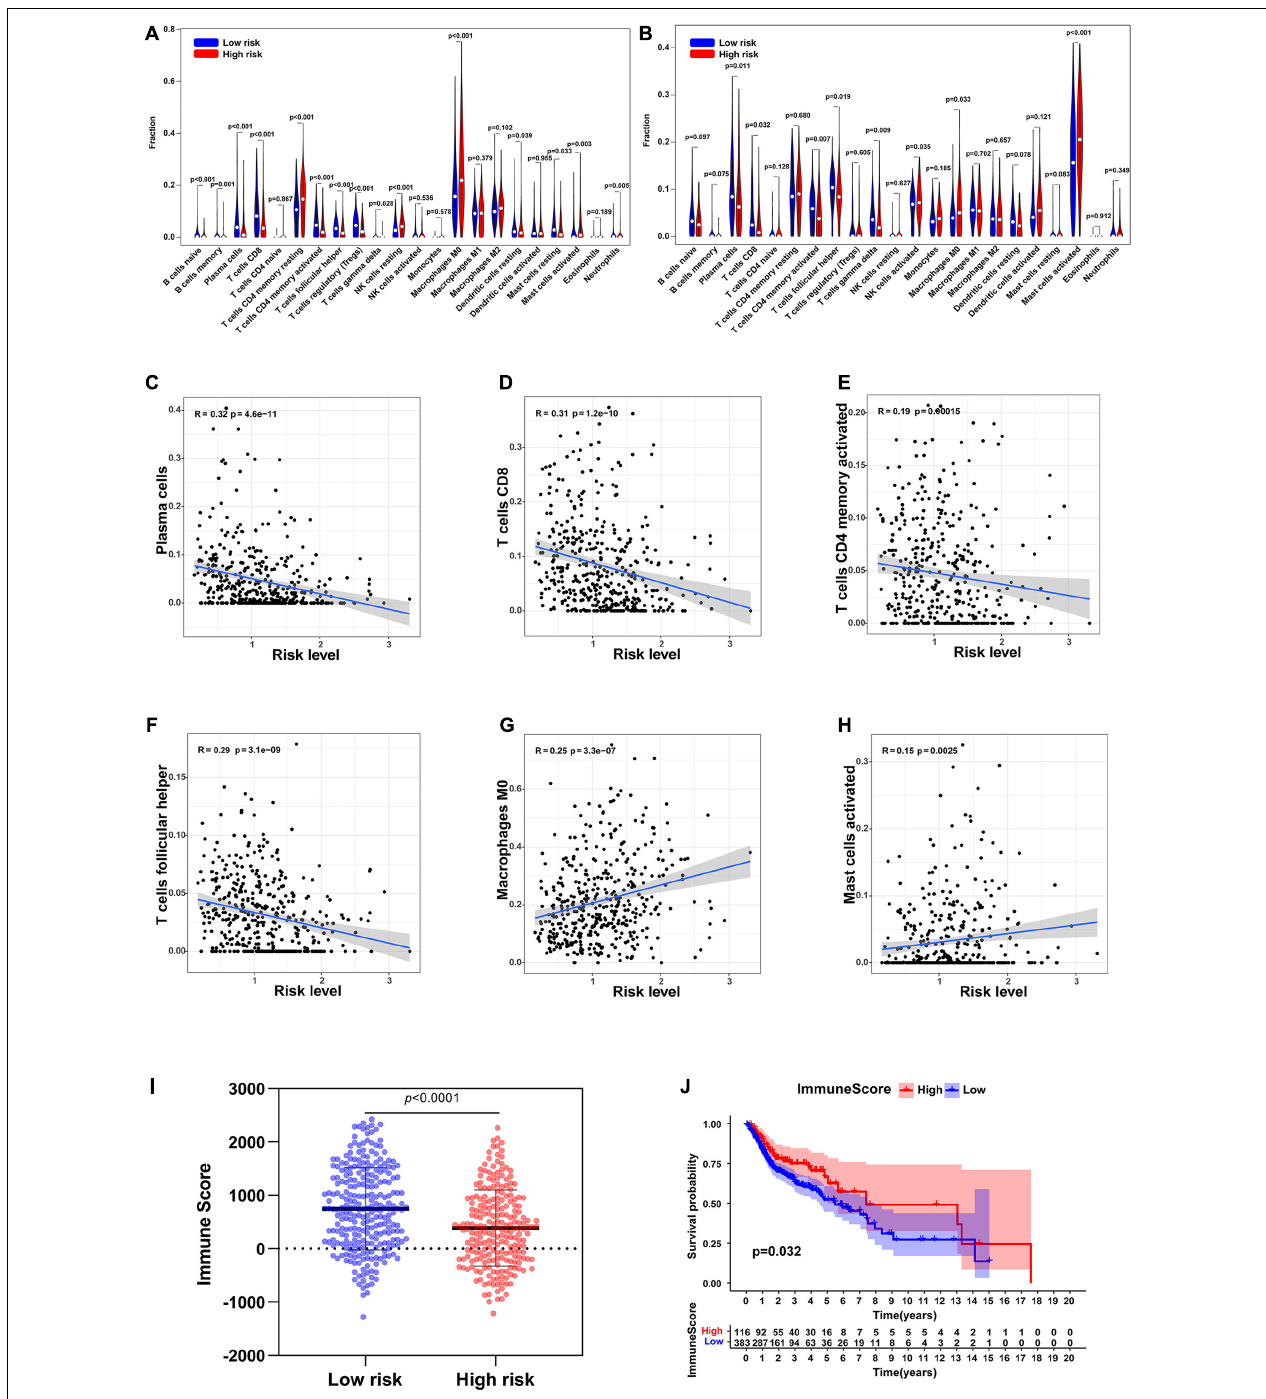
FIGURE 8 | Immune cell infiltration in low-risk and high-risk group. (A) Infiltration of 22 types of immune cells in TCGA. (B) Infiltration of 22 types of immune cells in GSE65858. (C–H) The relationship between the risk level and the infiltration levels of plasma cells, T cells CD8, T cells CD4 memory activated, T cells follicular helper, Macrophages M0, and Mast cells activated. (I) Immune scores in low-risk and high-risk groups. (J) Survival analysis of the immune score.